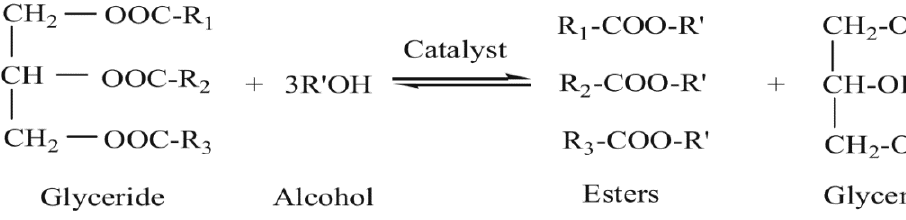
Figure 4. Biodiesel production by transesterification with short-chain alcohols (adapted from